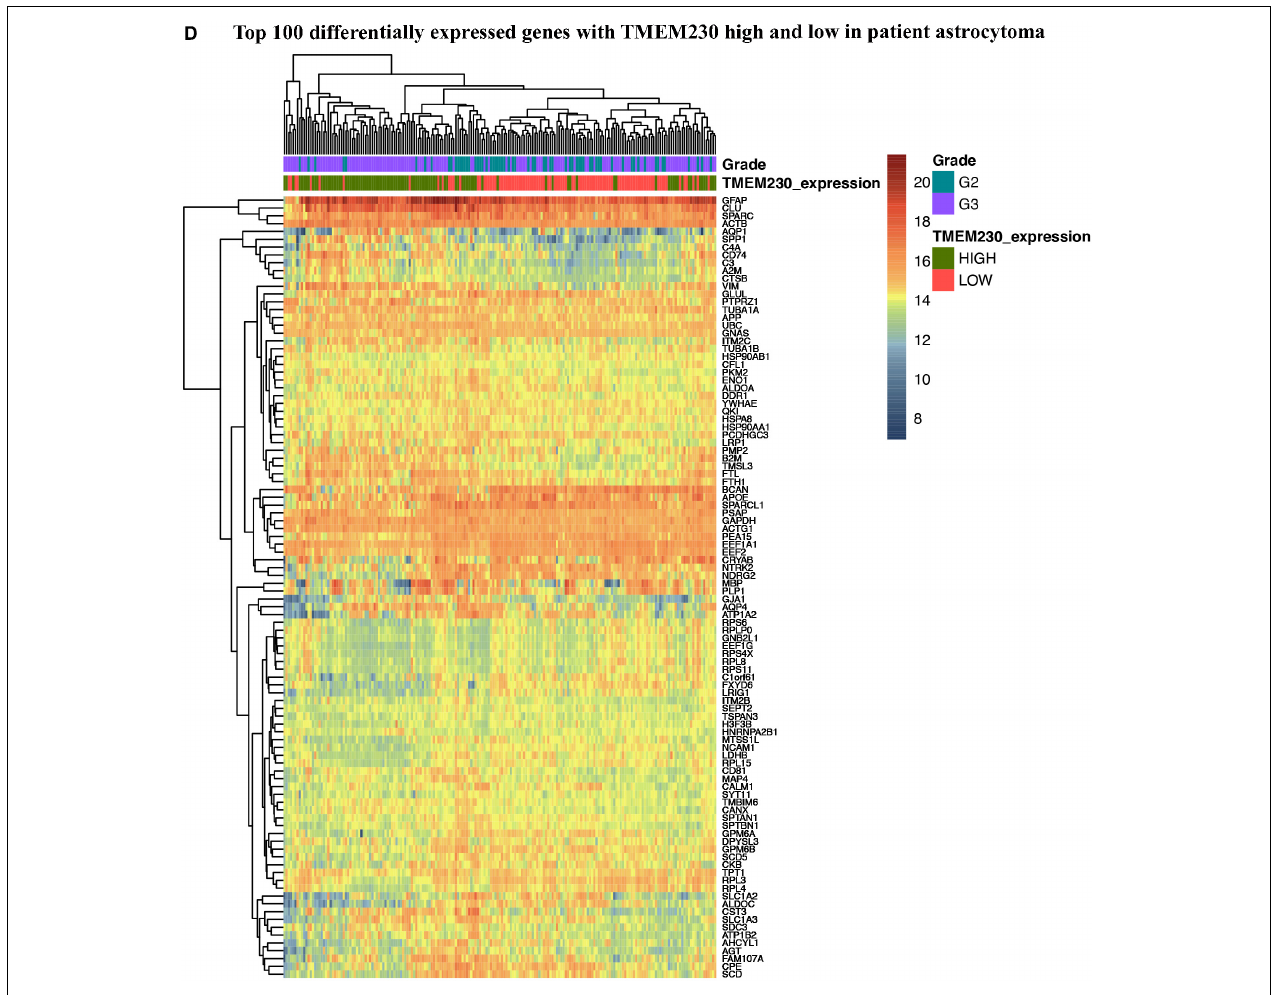
FIGURE 1 | Expression of TMEM230 in brain Glioblastoma Multiforme (GBM) and Low-Grade Gliomas (LGG) analyzed from The Cancer Genome Atlas. (A) Glioblastoma multiforme tumors showed significantly elevated level of TMEM230 mRNA compared to low-grade gliomas (unpaired t -test p < 0.0001). Low-grade gliomas consist of astrocytoma, oligoastrocytoma and oligodendroglioma patient samples. (B) Poor prognosis was correlated with high TMEM230 in low-grade gliomas. (C) Poor prognosis was correlated with high TMEM230 in astrocytoma (top), oligoastrocytoma (middle) and oligodendroglioma (bottom). Relationship between TMEM230 expression levels and prognosis of low-grade gliomas affected patients indicated that lower expression of TMEM230 was associated with increased overall survival. Each glioma subtype is indicated by the median of gene expression of TMEM230 . B and C analyses were generated from the Kaplan-Meier test based on the expression of medium TMEM230. (D) Representative heatmap displaying the most variable expressed genes for astrocytoma using the R with “pheatmap” package for which functional enrichment was generated with DAVID